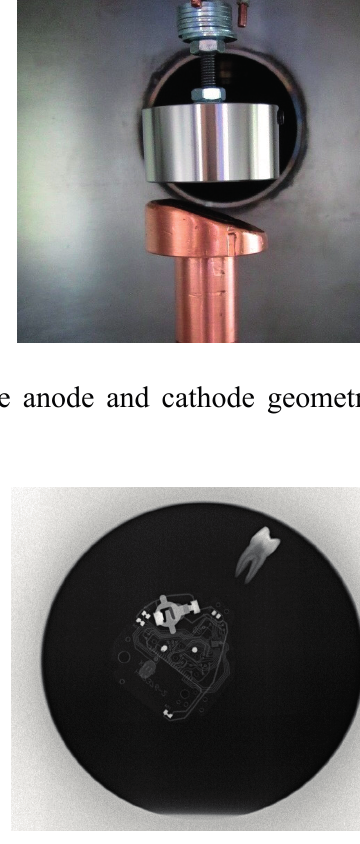
Figure 10. X-ray image of a circuit board and a tooth captured using the self-focusing X-ray